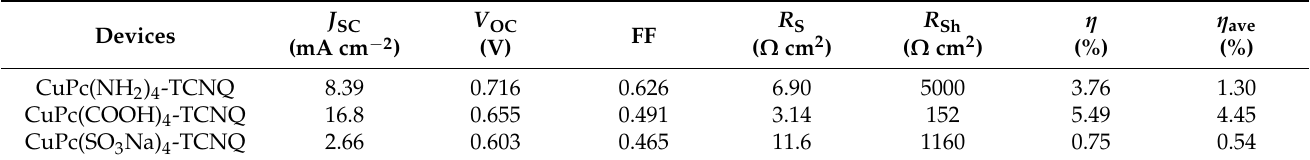
Table 1. Photovoltaic parameters of the perovskite solar cells as